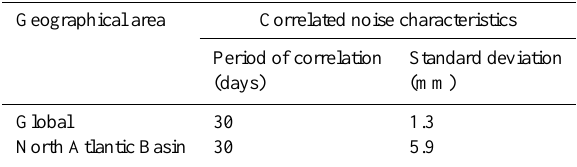
Table 1. Characteristics of correlated noise added to simulated mean sea level series at the global scale and in North Atlantic